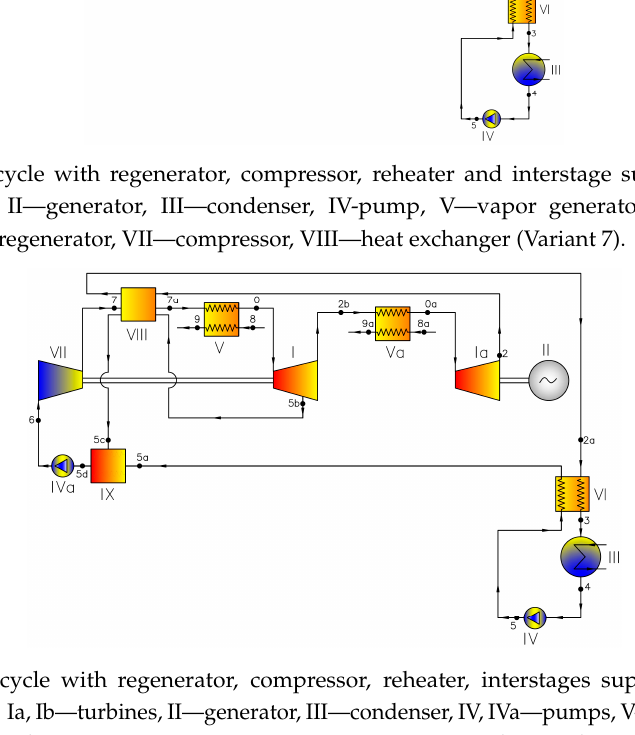
Figure 6. ORC cycle with regenerator, compressor, reheater, interstages superheater and heat exchanger; where: Ia, Ib — turbines, II — generator, III — condenser, IV, IVa — pumps, V — vapor generators, Va — interstage superheater, VI — regenerator, VII — compressor, VIII — heat exchanger, IX — vapor heater (Variant 8).